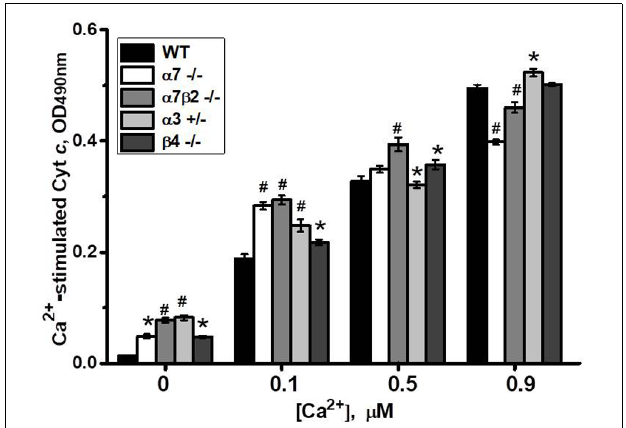
FIGURE 8 | Cyt c release from mitochondria of the wild-type (WT) or knockout mice in response to different Ca 2 + doses. Each column corresponds to mean ± SE, five mice per genotype; ∗ p < 0.05; # p < 0.0005 compared to WT.